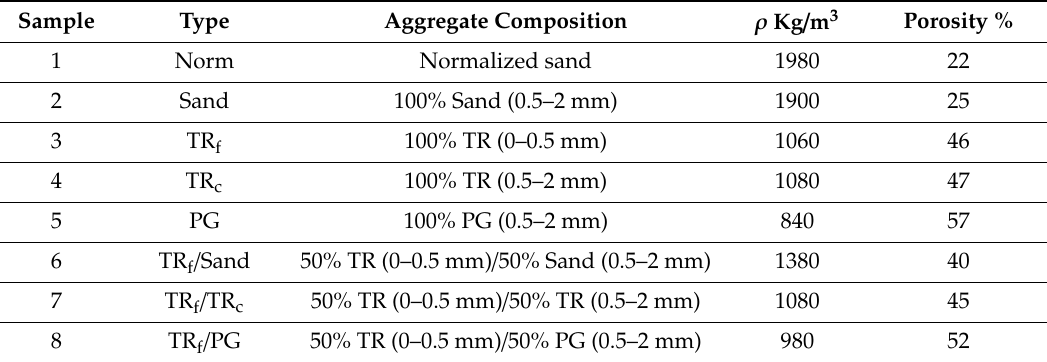
Table 2. Type, aggregate composition, specific weight ρ and porosity of the cement mortar specimens. Samples prepared with 225 g of water and 450 g of cement. TR f = fine tyre rubber, TR c = coarse tyre rubber, PG = porous